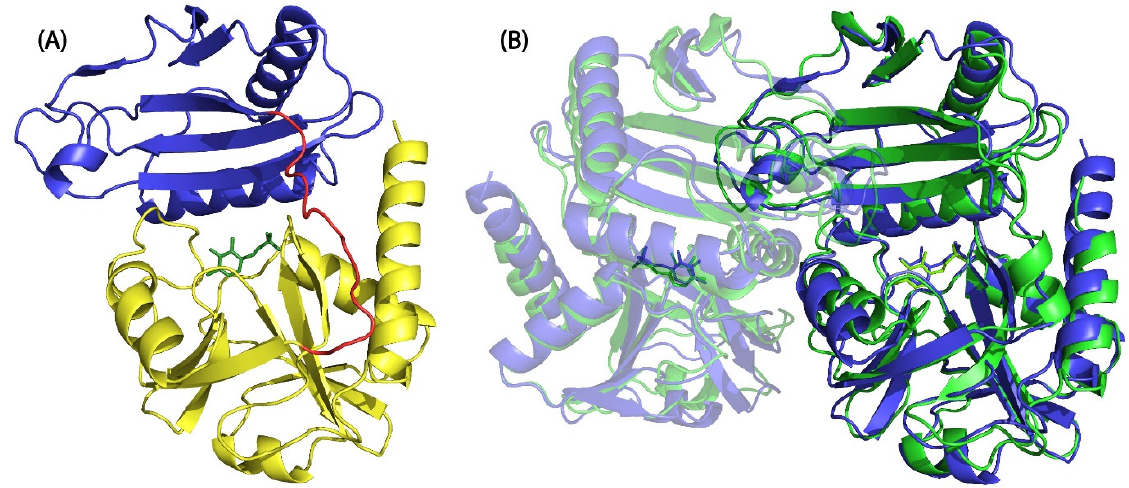
Figure 2. ( A ) The subunit of Halhy. The small domain is colored blue, the large domain is colored yellow, and the interdomain loop is colored red. The PLP molecule is shown as green sticks. ( B ) The active dimer of Halhy (blue) is superposed with the dimer of bsDAAT (green, PDB ID: 1DAA); the adjusted subunits of both structures are shown transparently.